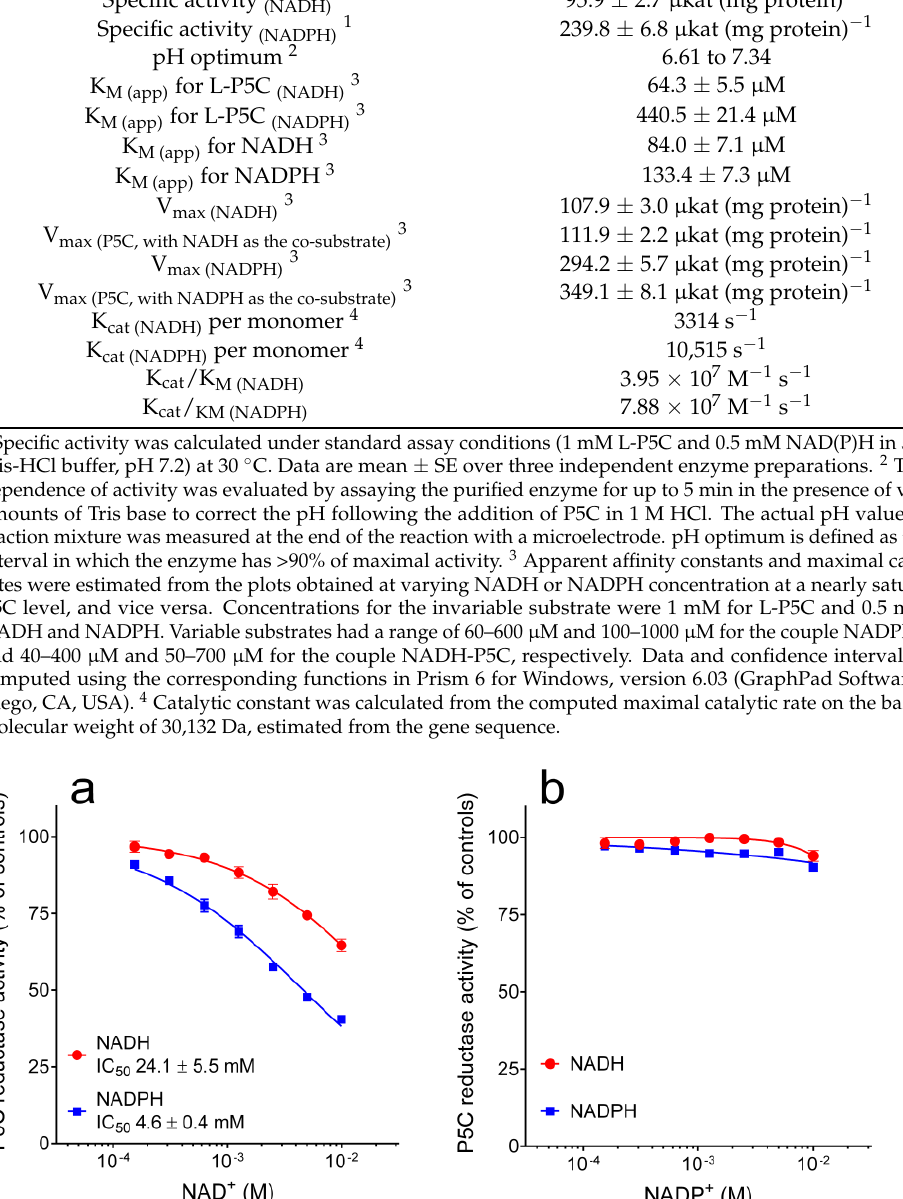
Figure 4. Effect of proline ( a ), arginine ( b ), and ornithine ( c ) on the activity of yeast P5C reductase. The purified enzyme was assayed in the absence or in the presence of increasing concentrations of a given amino acid, using either NADH or NADPH as the electron donor. Results were expressed as the percent of the activity obtained with untreated controls. For arginine and ornithine, added as hydrochlorides to prevent changes in the pH of the reaction mixture, controls received the same level of NaCl. Data are means ± SE over three replicates. Finally, the influence of increasing concentrations of salt was taken into account. Once again, a striking difference was found depending on which pyridine dinucleotide served as the electron donor. With NADH, the presence of salts up to 200 mM was com- pletely ineffective. On the contrary, with NADPH as the co-factor, enzyme activity was inhibited by 50% at around 100 mM (Figure 6). The comparison of the patterns obtained with salts with the same anion and different cations (Figure 6a,b and Figure 6c,d), and vice versa (Figure 6a,c and Figure 6b,d), strongly suggested that the effect is primarily due to the anion.